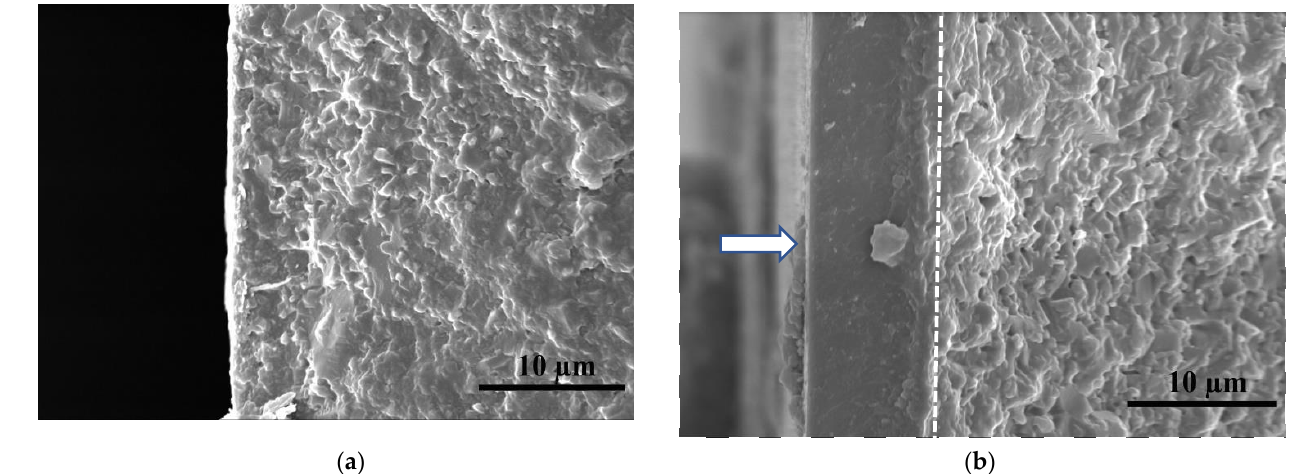
Figure 3. SEM images of the edge of ( a ) initial and ( b ) 167 MeV Xe ion irradiated (3.2 × 10 13 cm −2 ) silicon nitride samples. The direction of the ion beam incidence is indicated by an arrow. The border of the amorphized layer is marked with a dashed line.